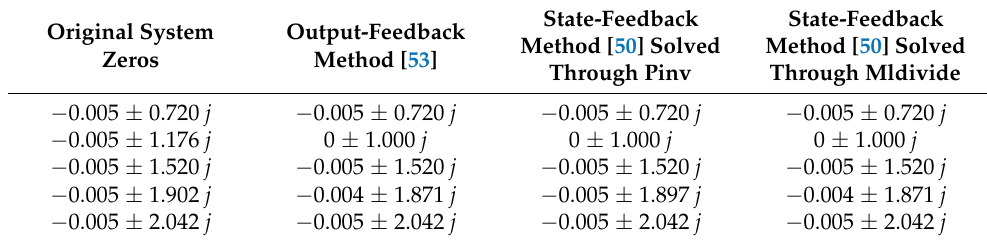
Table 4. Zeros of the original and modified receptance h 3,3 (j ω ) with the different controllers to assign a complex conjugate zero